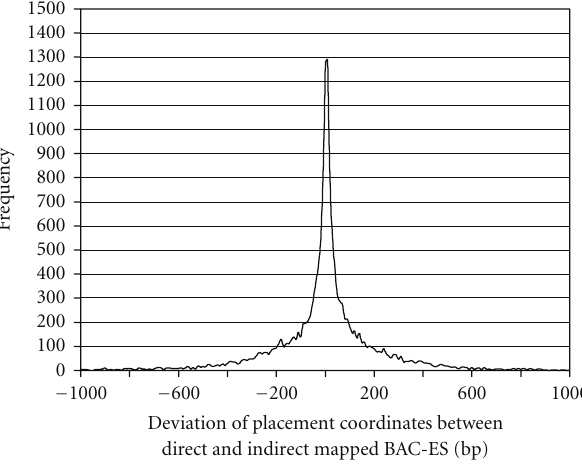
Figure 2: Placement error frequency distribution observed by BACs that were directly mapped to stickleback chromosomes as well as mapped indirectly by aligning them to seabass sequence that has been placed along the stickleback sequence before. Of the indirectly mapped BACs 96.7% had a placement error of less than 1000